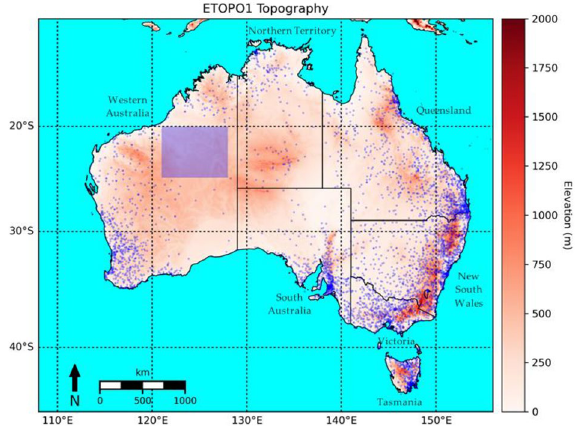
Figure 1. Typical rain gauge network coverage in Australia. The blue dots represent stations while the shading represents topography derived from the ETOPO1 dataset. The main topographical feature of the continent, the Great Dividing Range, can be seen running along the east coast of the continent, extending from northern Queensland to central Victoria. The blue rectangle represents a sub-domain used for validation of a gauge-sparse region. Figure created using Matplotlib 3.3.3 on